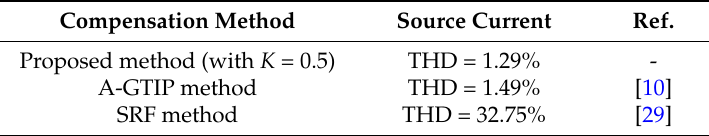
Table 5. Compensated load-terminal current. A-GTIP: advanced generalized theory of instantaneous power.